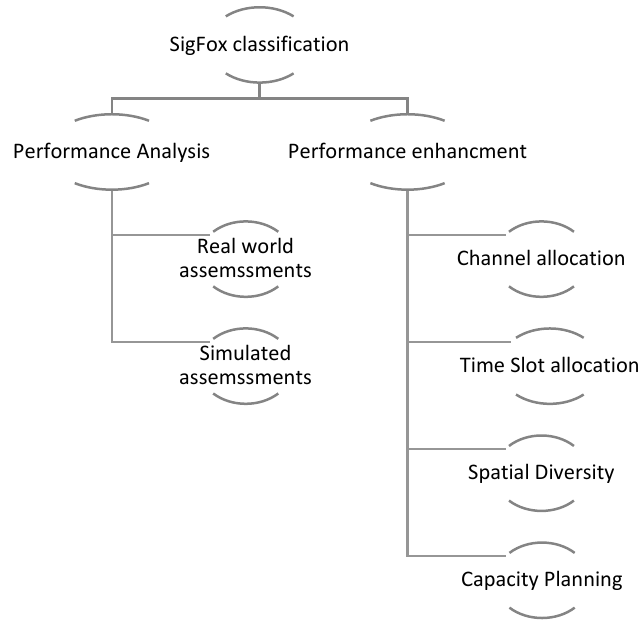
Figure 2. SigFox-related work classi fi cation.